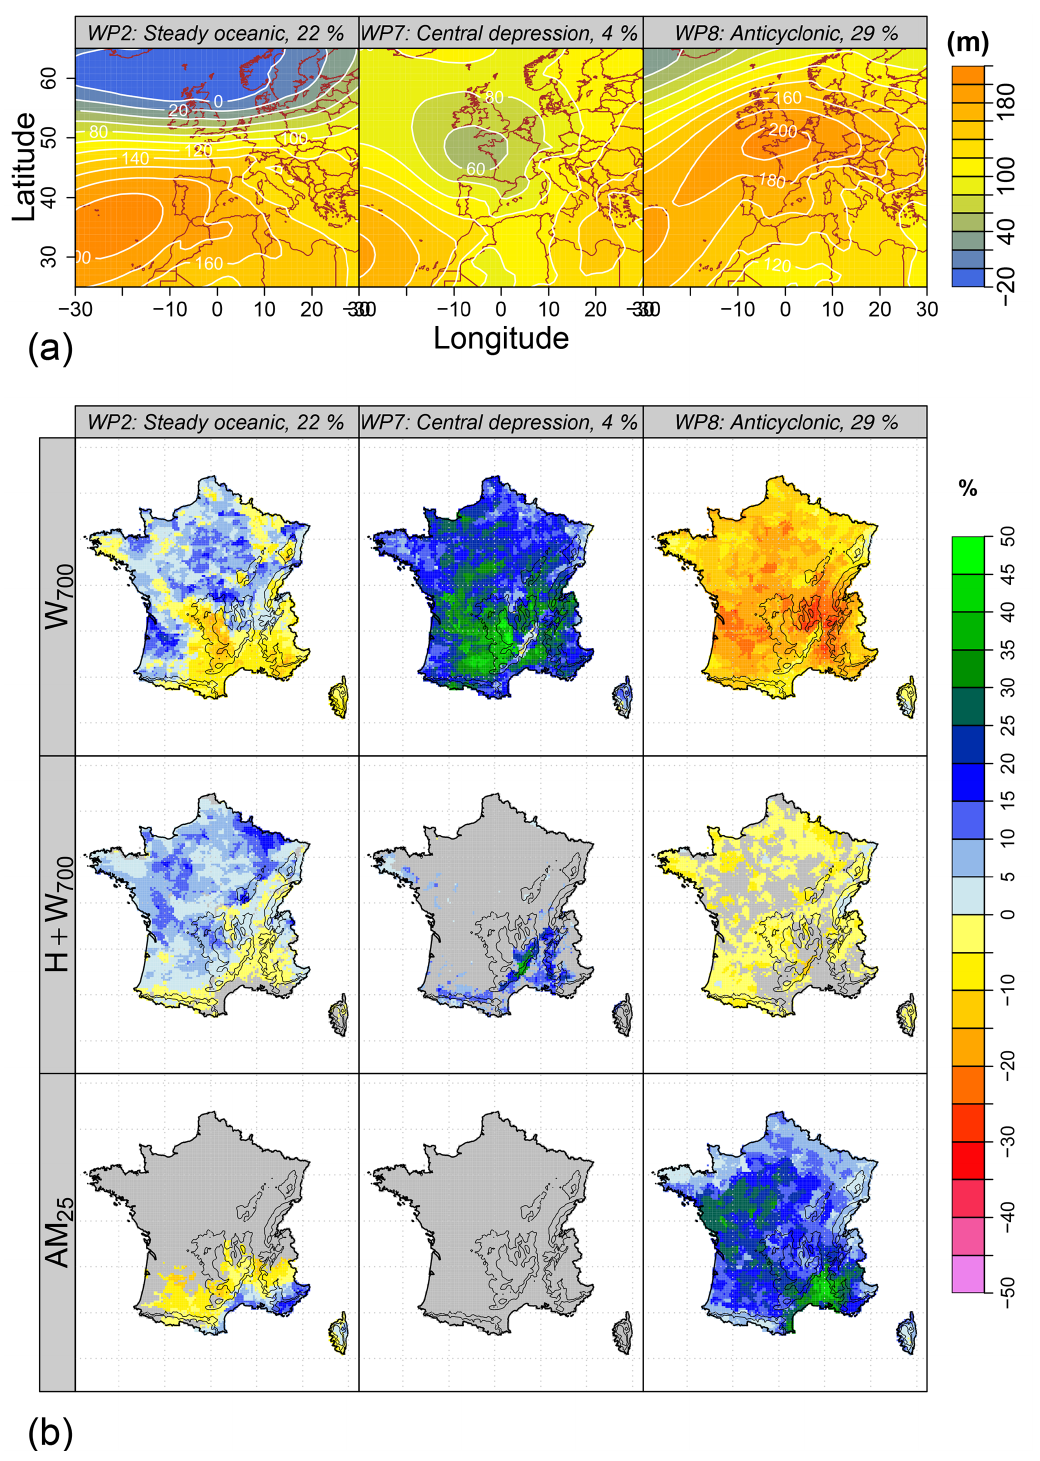
Figure 11. (a) Mean geopotential height at 1000hPa for three WPs (Garavaglia et al., 2010). (b) For each WP, difference (%) in selection frequency with the all-days case. Results for two regression structures ( W 700 and W 700 + H ) and for AM 25 . The predictand is the precipitation amount. A positive (negative) difference indicates an extra selection (reduced selection). Gray grids: same as in Fig.